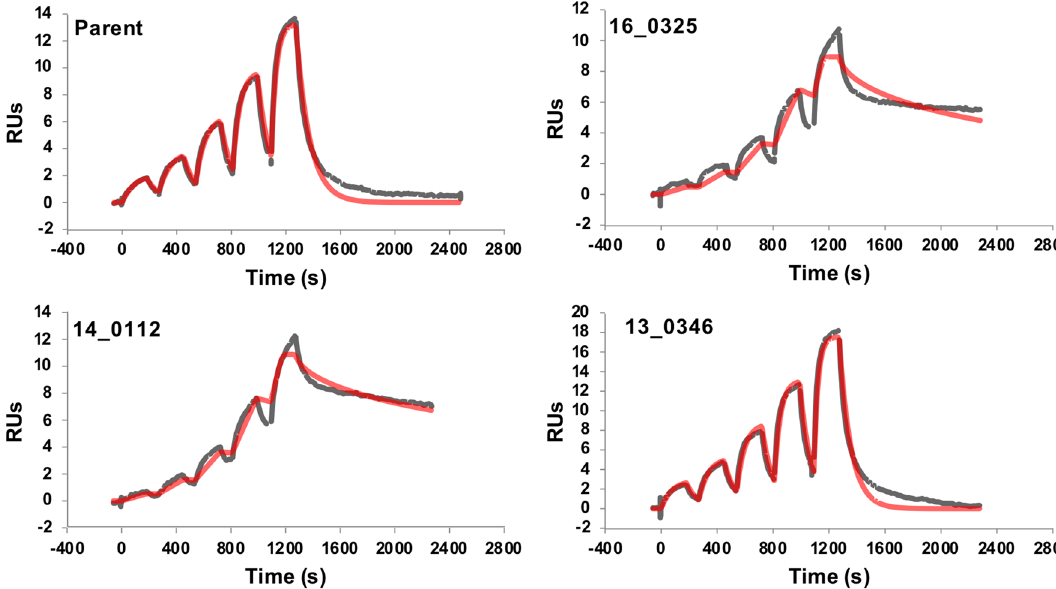
Figure 5. SPR sensorgrams. The red curves represent the global fits of the data to a 1:1 bimolecular interaction model.